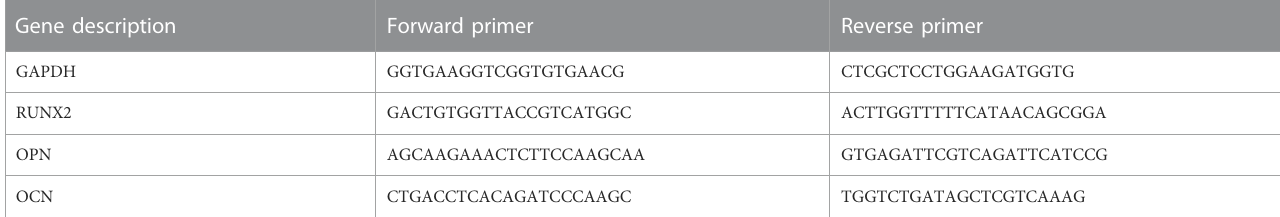
TABLE 1 Primer sequences of target genes for qRT-PCR. Gene